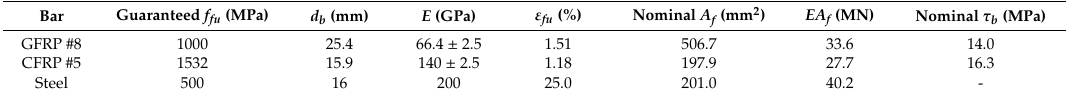
Table 2. Mechanical properties of the tensile rebar.